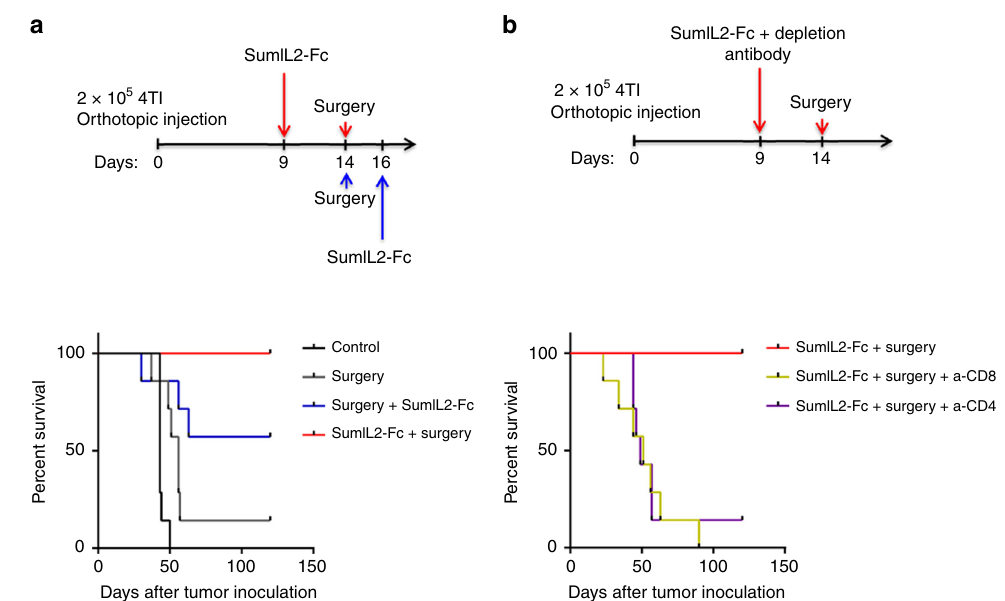
Fig. 6 Preoperative therapy with sumIL-2 enhances ef fi cacy in eradicating metastatic disease. BALB/c WT mice ( n = 7/group) were injected with 2 × 10 5 4T1 mammary carcinoma cells into the mammary fat pad. a As indicated in the schematics, one group of mice were i.p. treated with 10 μ g sumIL-2-Fc on days 9, 11, and 13 before surgery; one group of mice were treated on days 16, 18, and 20 after surgery. All primary tumors were resected on day 14, except for the no-surgery group which as a control. b Groups of mice ( n = 7/group) were treated with preoperative 10 μ g sumIL-2-Fc on days 9, 11, and 13. All primary tumors were resected on day 14. For depletion of CD4 + or CD8 + T cells, 200 μ g anti-CD4 or anti-CD8 depletion antibody was injected on the